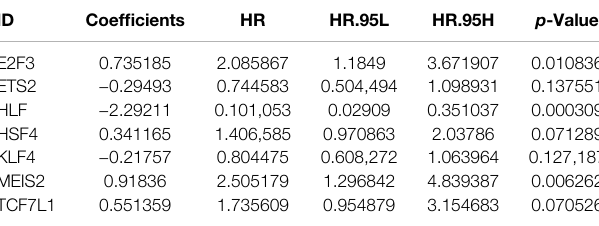
TABLE 2 | The results of multivariate Cox analysis in